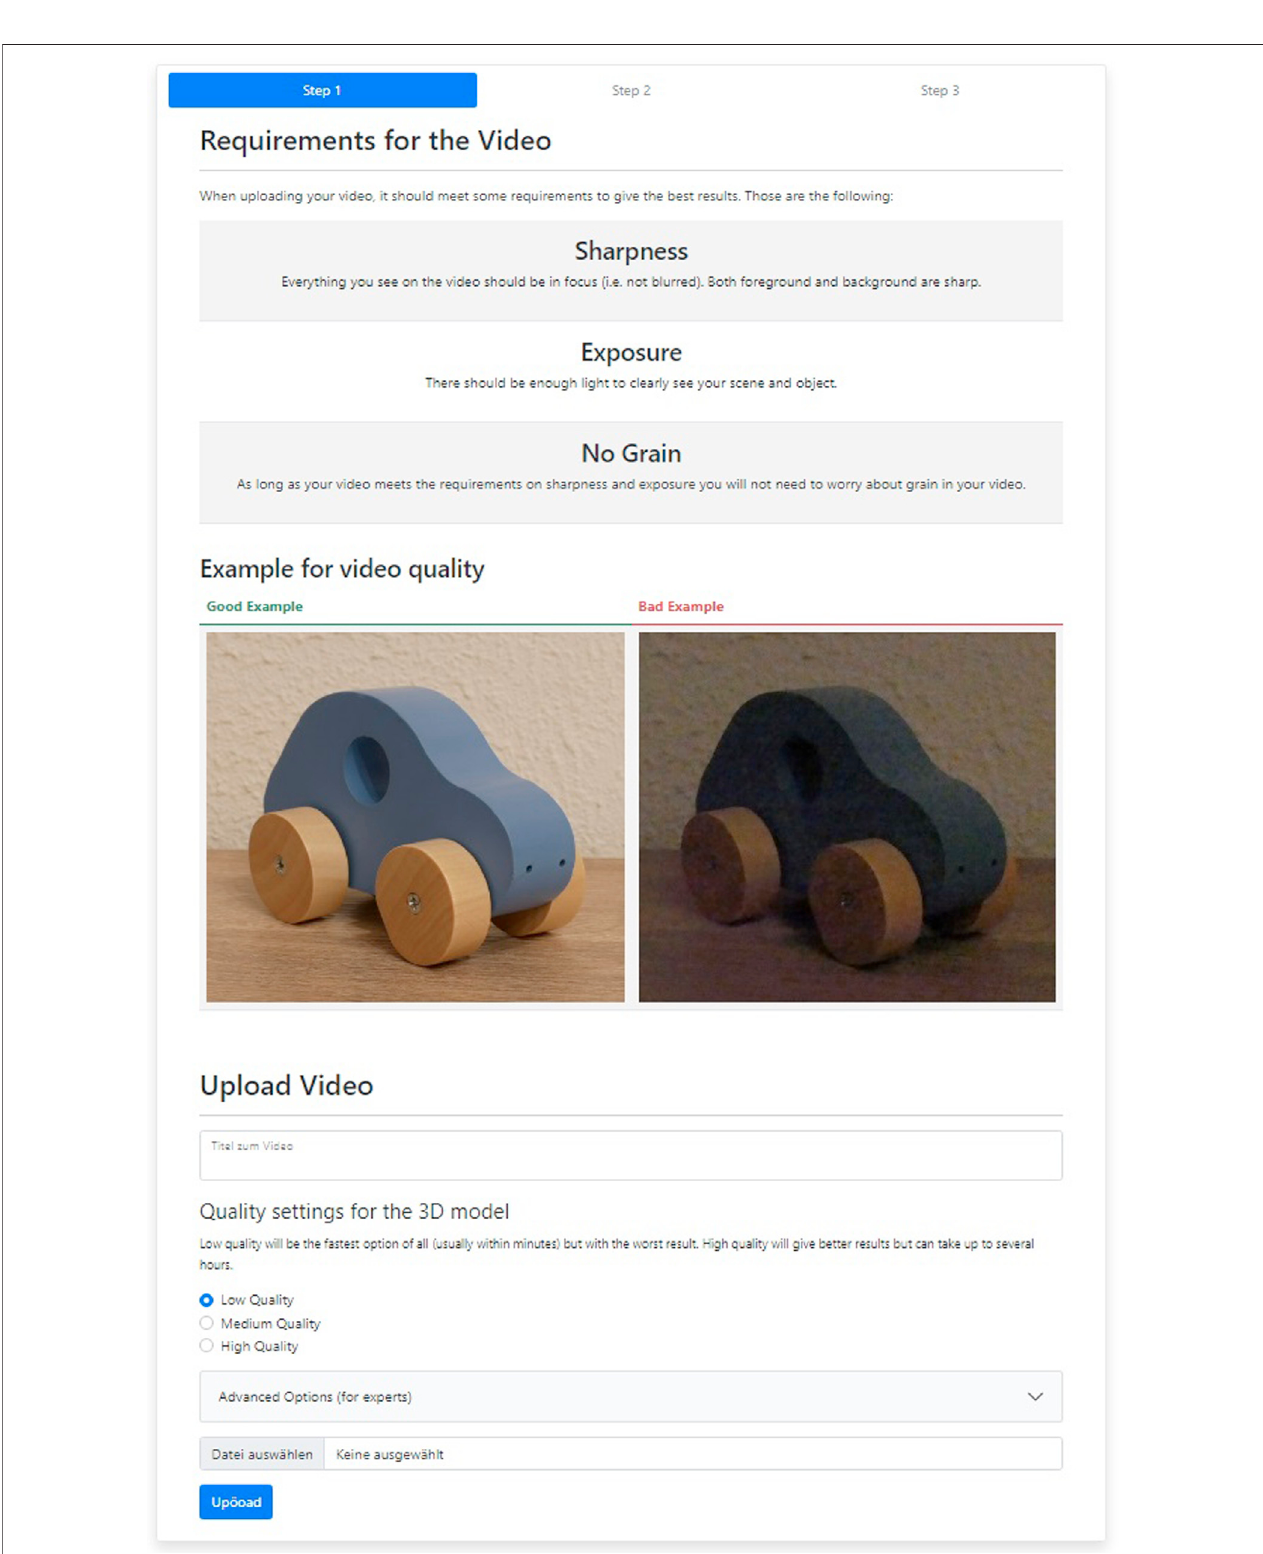
FIGURE 2 | Start page of the web interface including an example of suitable and unsuitable image frames.